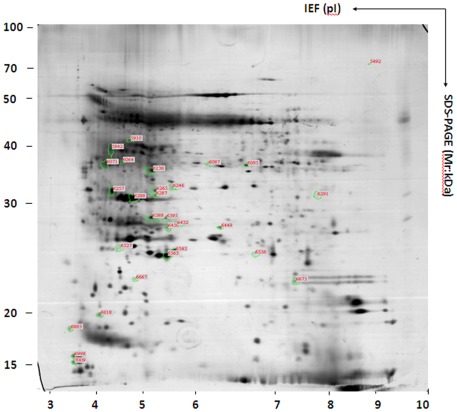
2-DE image analysis of total proteins from the tobacco leaves of Groups E.The spots were visualized by silver staining and detected using the DeCyder software. Quantitative image analysis revealed the protein spots with significantly different intensity (p<0.05) (by more than 1.5-fold) when compared with the B group.